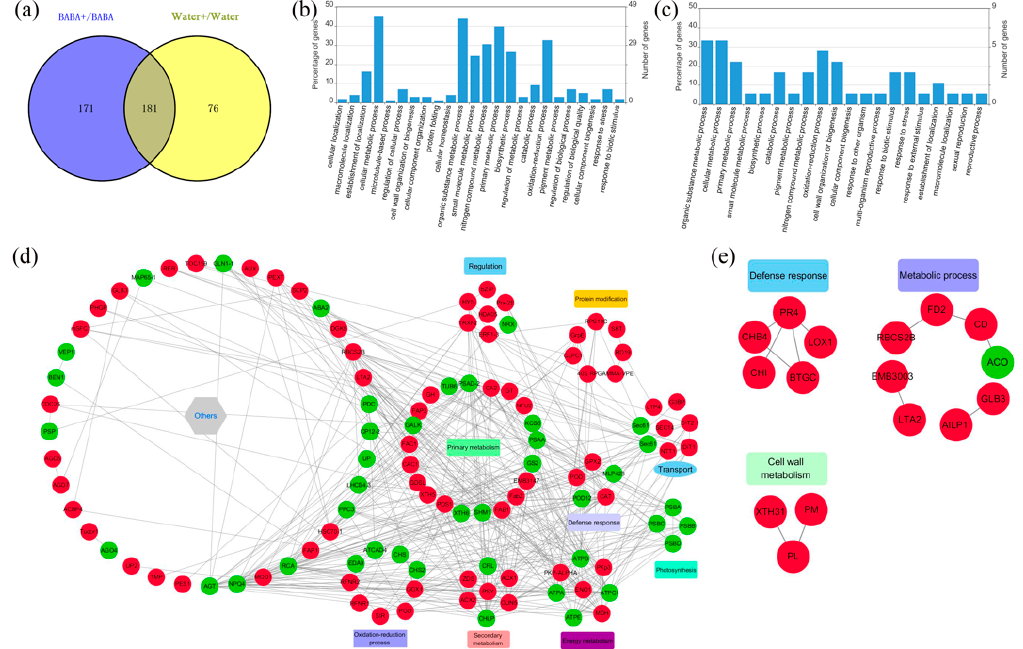
Figure 5. Di ff erentially expressed proteins in response to C. gloeosporioides infection in primed fruit and non-primed plants. ( a ) Venn diagrams showing the number of di ff erentially regulated proteins. BABA + represents BABA + C. gloeosporioides fruits while Water + represents Water + C. gloeosporioides fruits. ( b ) GO analysis of the proteins only di ff erentially regulated in BABA primed fruit. ( c ) GO analysis of the proteins di ff erentially expressed between BABA + C. gloeosporioides and Water + C. gloeosporioides . ( d ) Protein–protein interaction (PPI) analysis of proteins only di ff erentially regulated in BABA primed fruit. ( e ) PPI analysis of proteins di ff erentially expressed between BABA + C. gloeosporioides and Water + C. gloeosporioides . Red color in D and E represented upregulation while green color represented downregulation.